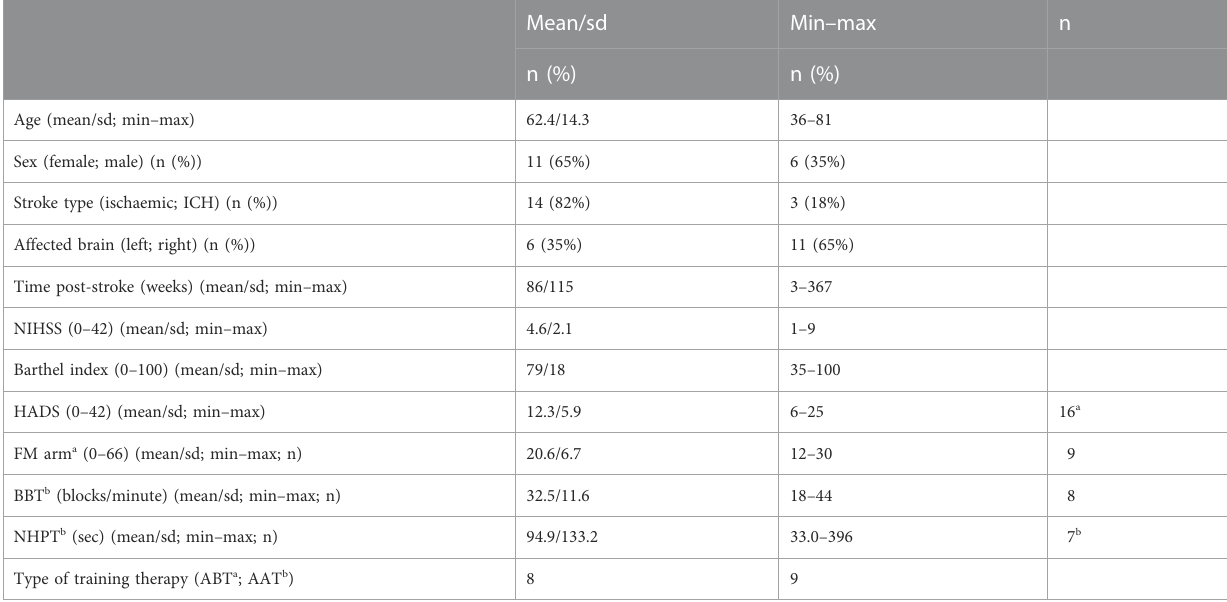
TABLE 1 Study population characteristics (n =